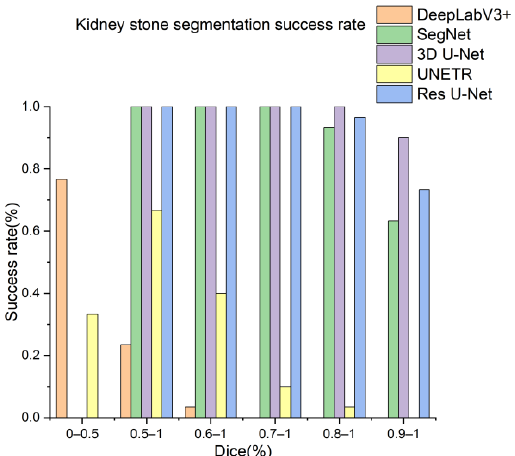
Figure 12. Kidney stones segmentation success rate of segmentation networks trained with the pro-